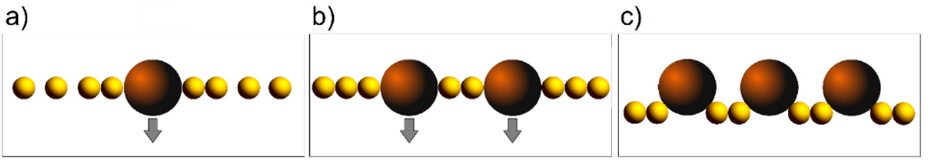
Figure 8. ( a – c ) Scheme of transport of solid particles through the emulsion structure at different concentrations (amounts) of particles.